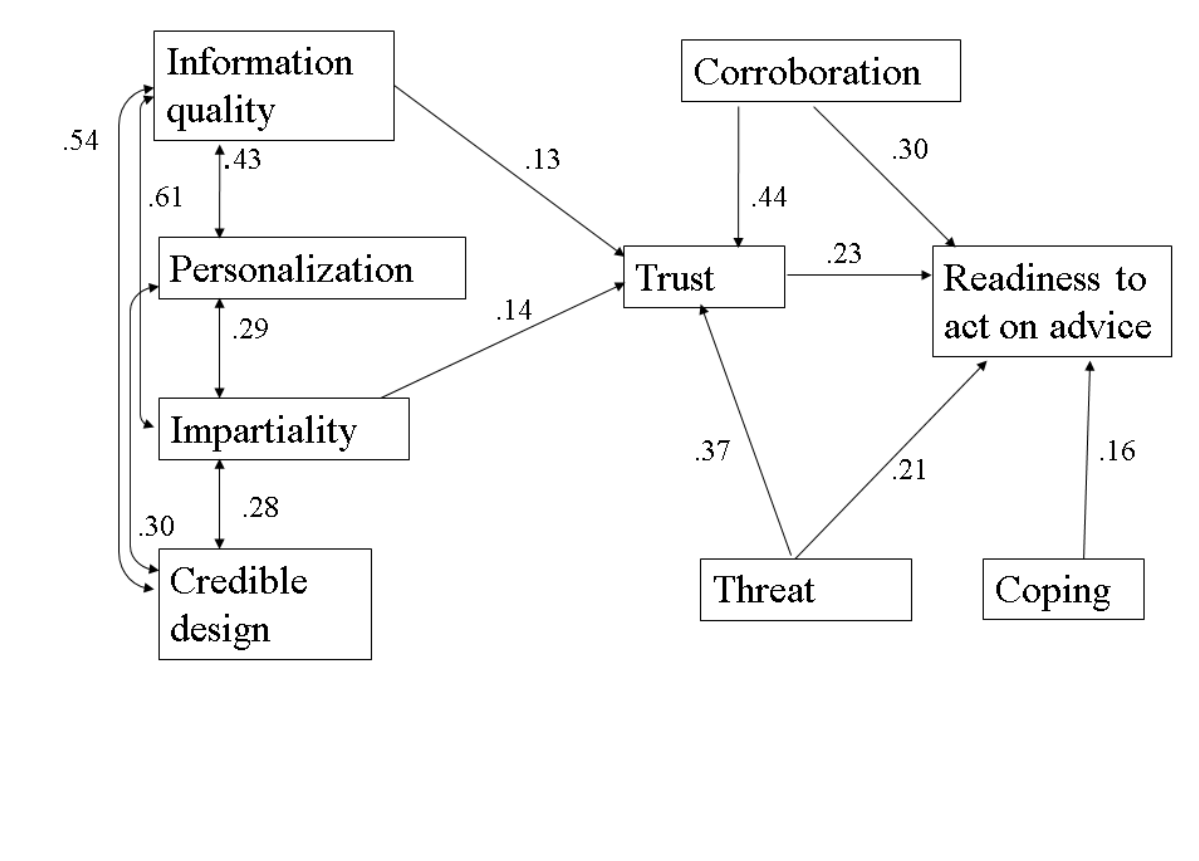
Figure 1. The final model, showing the significant path coefficients (P <